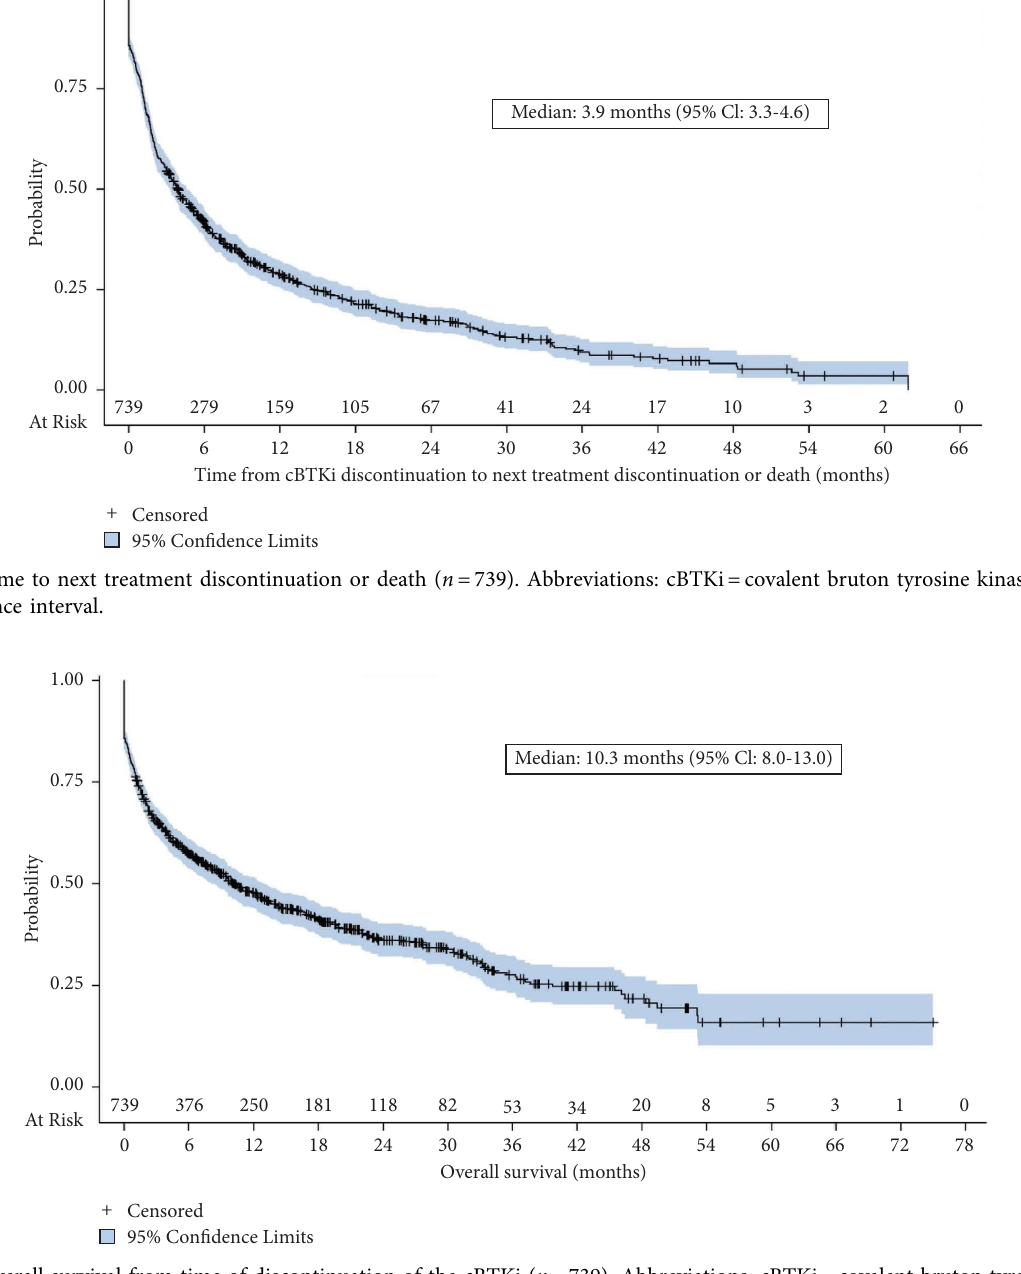
Figure 5: Overall survival from time of discontinuation of the cBTKi ( n � 739). Abbreviations: cBTKi � covalent bruton tyrosine kinase inhibitor; CI � confdence interval.